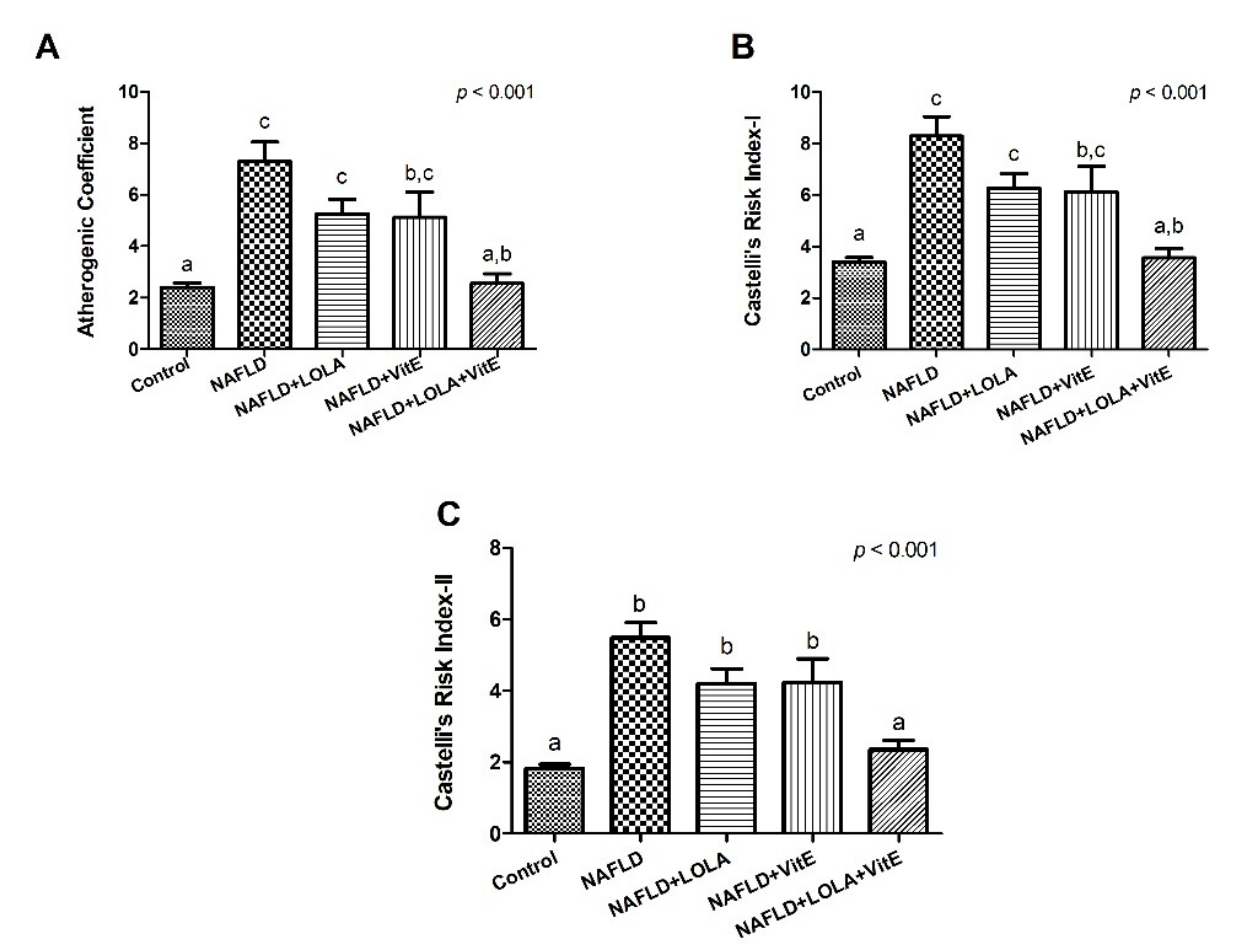
Figure 2. Atherogenic ratios. ( A ) Atherogenic coefficient (AC), ( B ) Castelli’s Risk Index (CRI)-I, and ( C ) CRI-II. Data expressed as mean ± standard deviation, Tukey’s test. Different letters indicate a significant difference between groups ( p < 0.05). LOLA: ornithine aspartate; NAFLD: nonalcoholic fatty liver disease, and VitE: vitamin E.